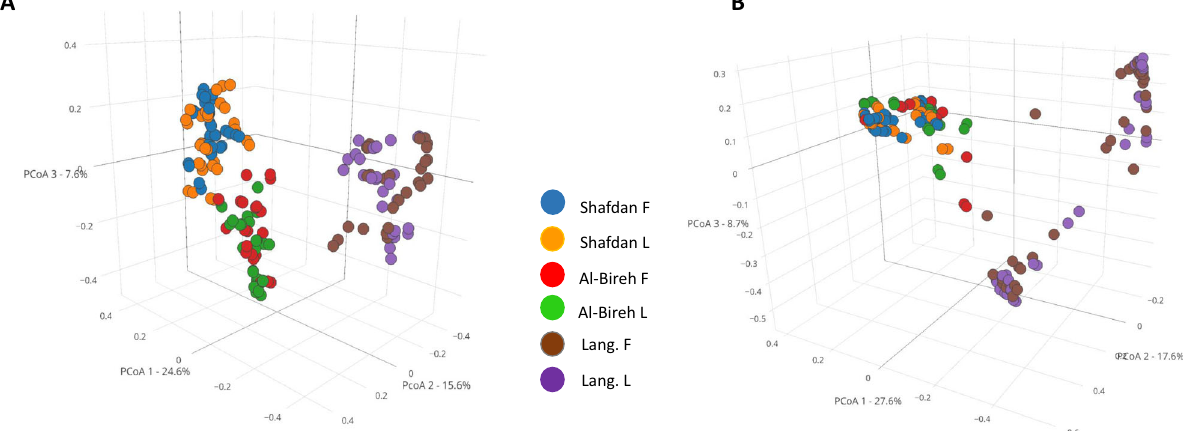
Fig. 2 Floc and liquor BALO community structure. PCoA of Bdellovibrionales ( A ) and Bacteriovoracales ( B ) community distribution of the fl oc (F) and liquor (L) fractions at the Shafdan (SH), Al-Bireh (AB), and Langenreichenbach (LB) WWTPs, using Bray – Curtis distances according to 16S rRNA gene community composition. Each symbol represents a single time